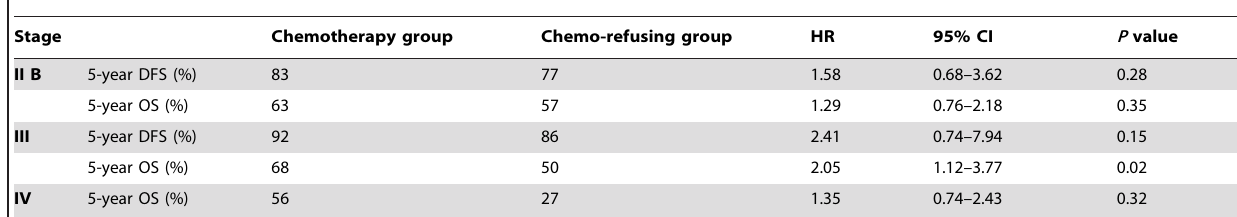
Table 4. Relationship between survival and chemotherapy.